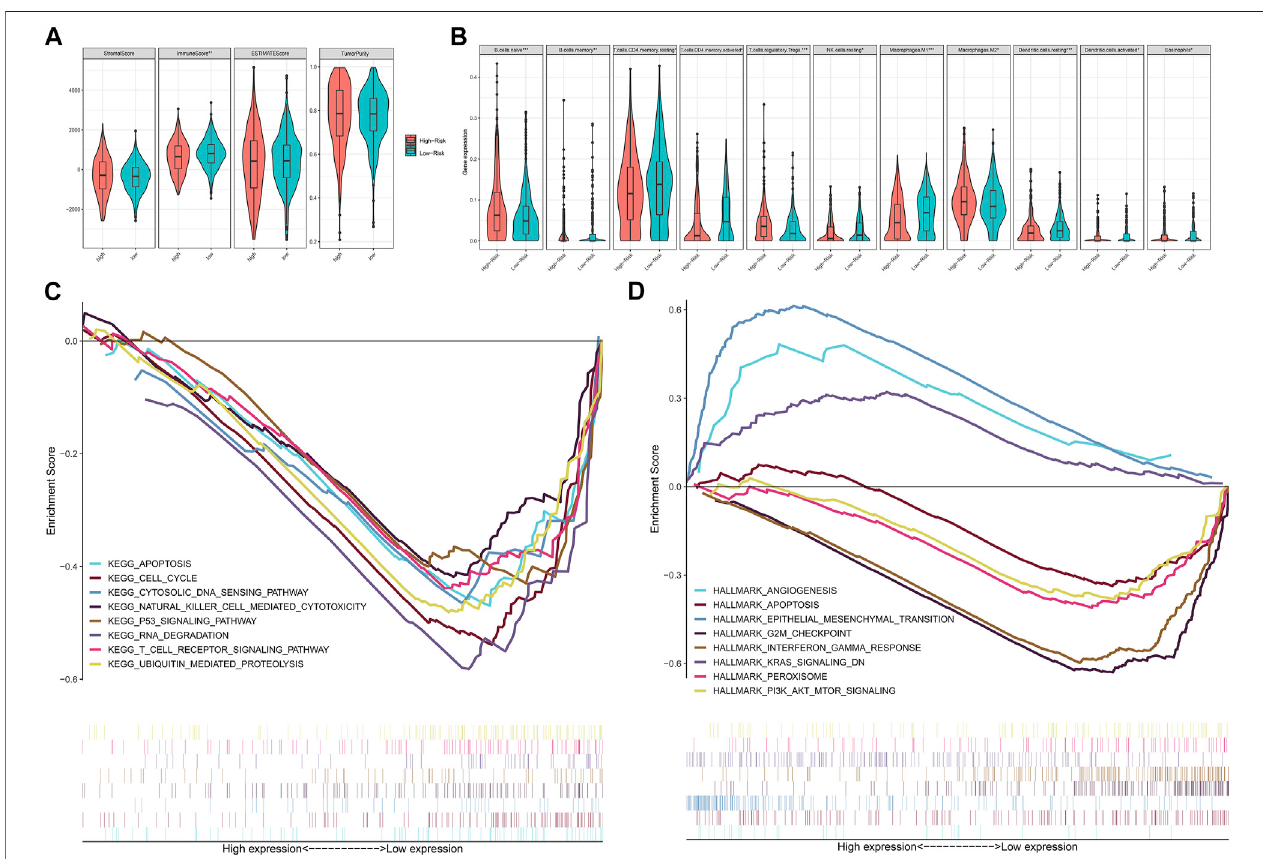
FIGURE 6 | Characteristics of the PRM-scores scoring model for colon cancer patients. (A) The level of stromalScores, immuneScores, ESTIMATEScores, and tumorPuritycalculatedwithESTIMATEinhigh-andlow-PRM-scoresgroups. (B) Theleveloftumormicroenvironment(TME)cellin fi ltrationinhigh-andlow-PRM-scores groups: high PRM-scores, red; and low PRM-scores, blue. The upper and lower ends of the boxes represent the interquartile range of values. The lines in the boxes representmedian value, and black dots showoutliers.The asterisks represent thestatistical p -value. Mann – Whitney Utest. * p < 0.05; ** p < 0.01; *** p < 0.001; p ≥ 0.05,notsigni fi cant. (C) TheenrichedgenesetsinKyotoEncyclopedia ofGenesandGenomes(KEGG)bysampleswithhigh-risksample.Andonlyseveralleadinggene setsaredisplayedintheplot. (D) EnrichedgenesetsinHallmarkcollectionbysamplesofhigh-risksample.Onlyseveralleadinggenesetsareshownintheplot.Eachline represents one particular gene set with unique color, and upregulated genes are located in the left approaching the origin of the coordinates; by contrast, the downregulatedgenesareontherightofthe x -axis.Onlygenesetswithnominal(NOM) p < 0.05andfalsediscovery rate(FDR) q < 0.05wereconsideredsigni fi cant.And only several leading gene sets are displayed in the